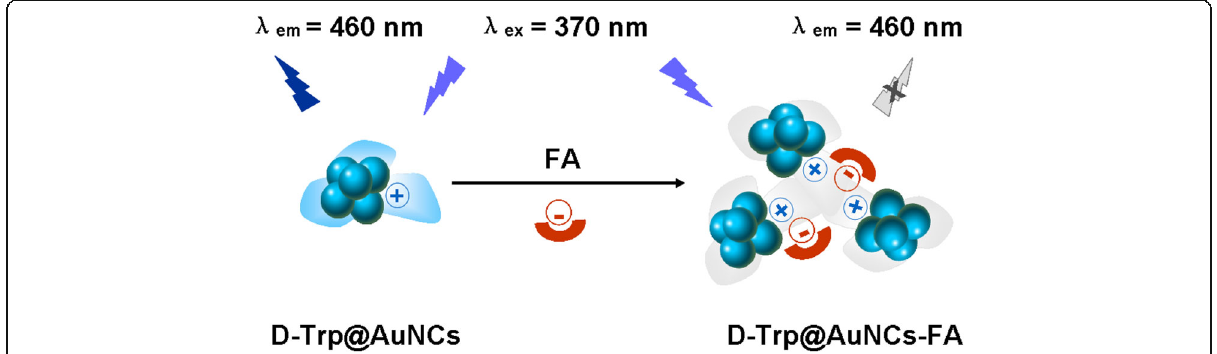
Fig. 4 Schematic illustration of FA-mediated fluorescence quenching of D -Trp@AuNCs